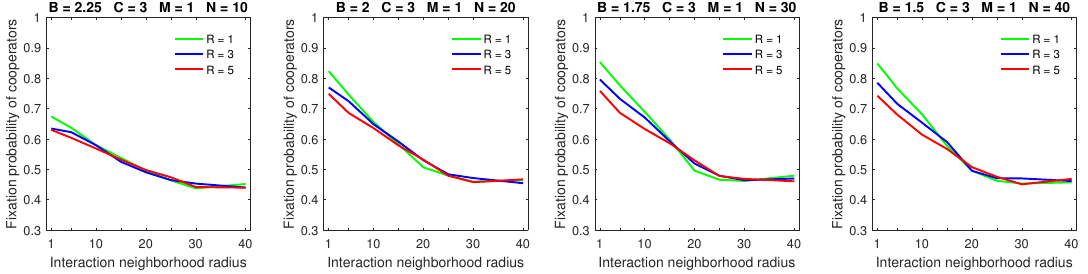
Figure 5. Increasing the dispersal range for low mobility rate M = 1 has a small negative effect on the fixation probability of cooperators when the interaction neighborhoods are sufficiently small in the deterministic dispersal